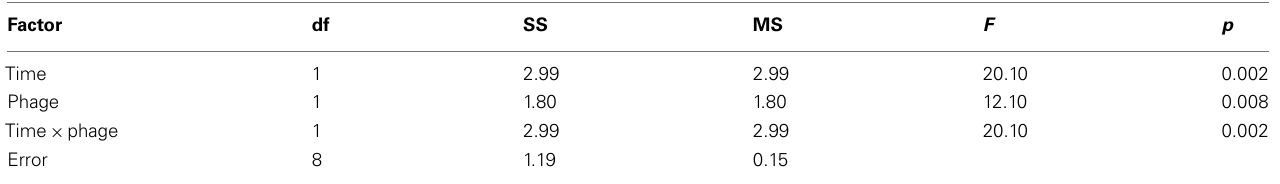
Table 1 |ANOVA results on the number of morphotypes (time-averaged for days 8–10) for focal genotypes introduced 24h before the competitor genotype.